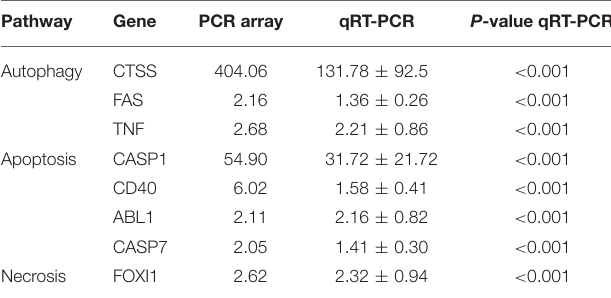
TABLE 1 | Changes in gene expression in dengue virus type 2 (DENV-2)-infected hair-follicle dermal papilla cells (HFDPCs).